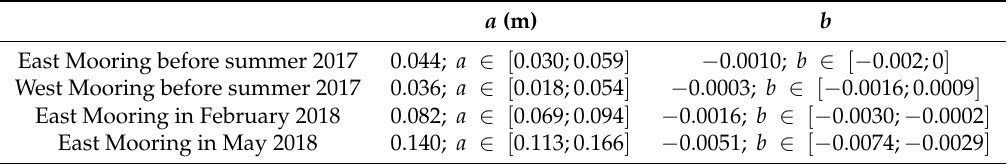
Table 1. LSE for a and b and their 95% confidence bounds in